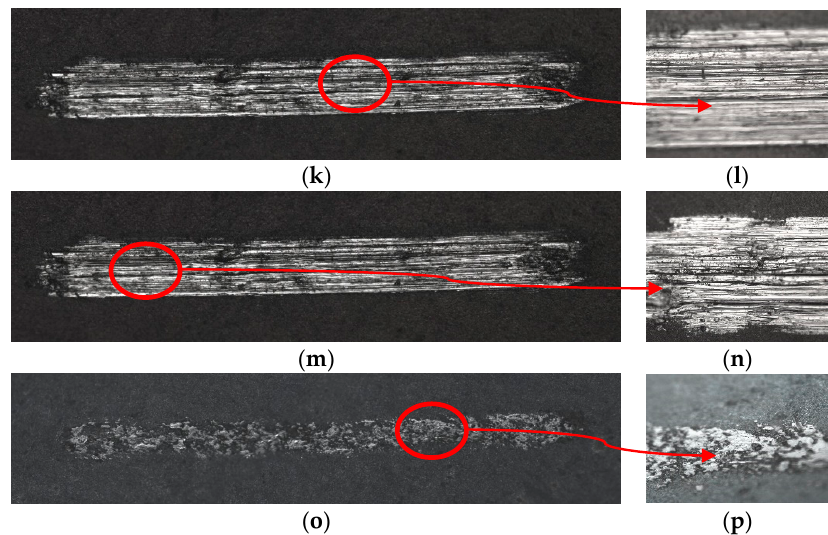
Figure 9. Low- and high-magnification optical micrographs of worn scar on ( a , b ) substrate, ( c , d ) anodized substrate annealed in air atmosphere at ( e , f ) 200 °C, ( g , h ) 400 °C, and ( i , j ) 600 °C and annealed in Ar gas at ( k , l ) 200 °C, ( m , n ) 400 °C, and ( o , p ) 600 °C. Table 3. Wear loss of different samples.